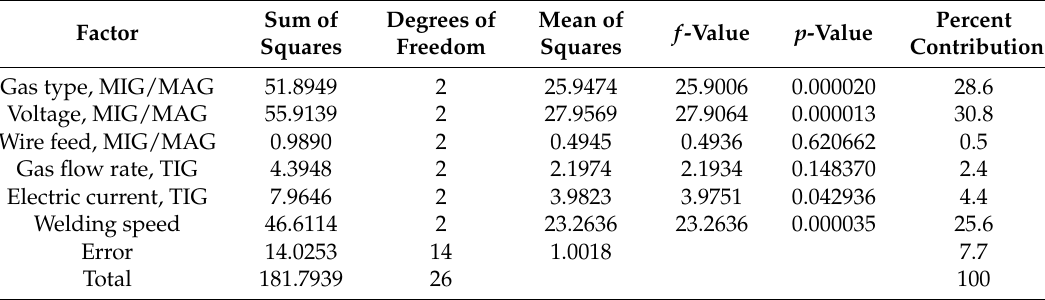
Table 4. Variance analysis for the heat-affected zone (HAZ).